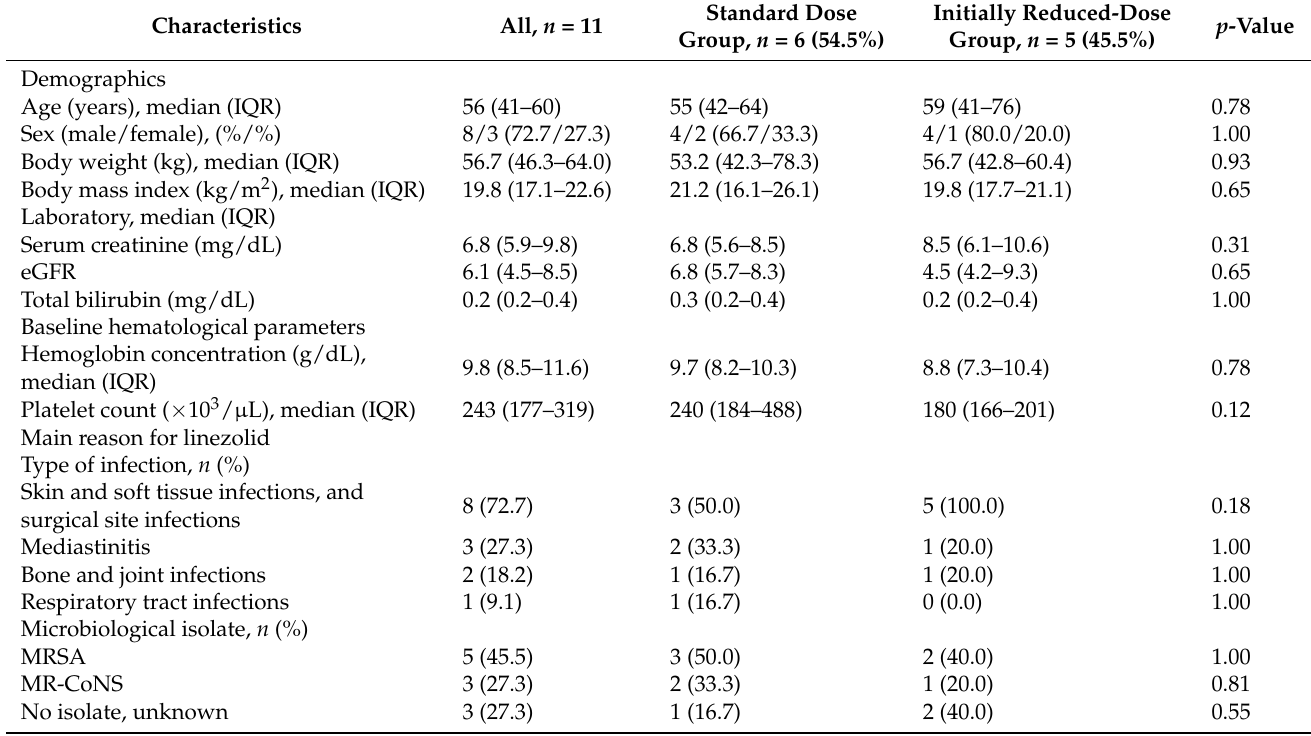
Table 1. Characteristics of episodes in the standard-dose group and initially reduced-dose group.